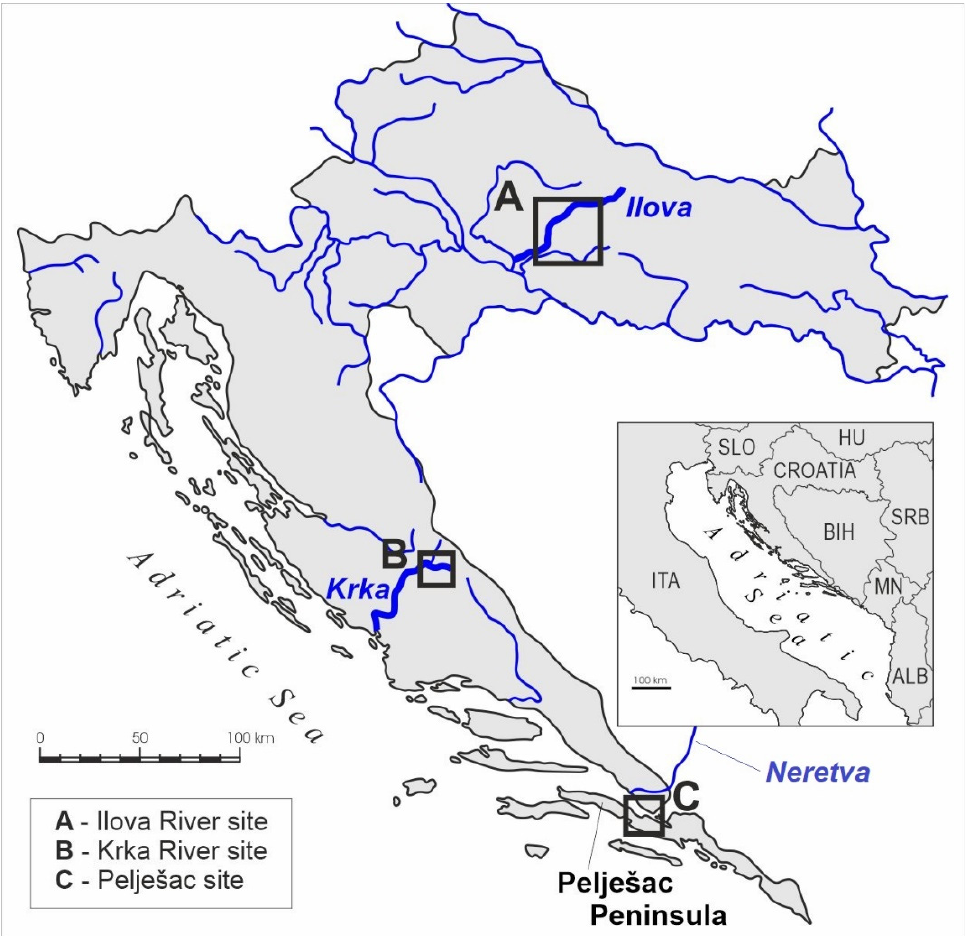
Figure 1. Locations of aquaculture sites: ( A ) Ilova River site, ( B ) Krka River site, and ( C ) Pelješac site. ( A – C ) Squares are matching Figure 2a, Figure 3a and Figure 4a, respectively. Note that Neretva River is the only river near the Pelješac study site ( C